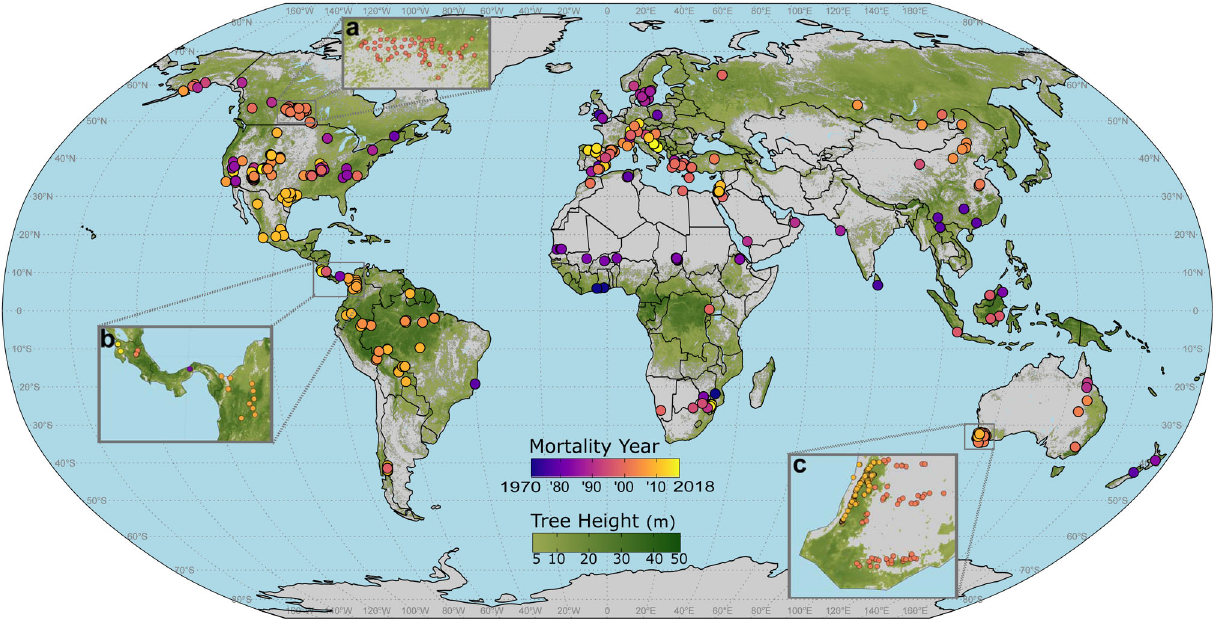
Fig. 1 Global distribution of hotter-drought tree mortality plots. Geo-referenced tree mortality plots ( n = 1303) in the database. Dots are color coded according to the year of mortality. Each point has been precisely georeferenced. Insets show examples of dense plot networks in Canada, Central America, and Southwest Australia. To illustrate the extent of global forests, a background layer in green shows canopy height 54 , with darker green shading indicating taller forests. Inset a shows a broad plot network from aspen die-off during drought in Canada. Inset b shows dense plot networks in Costa Rica, Panama, and Colombia. Inset c shows plots in the Jarrah and Wandoo forests of Southwest